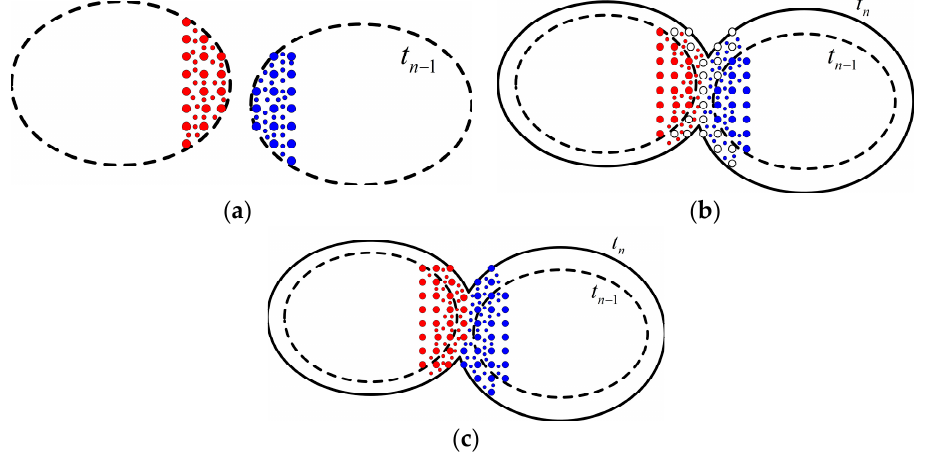
Figure 2. Schematic representation of the particle level set method for polycrystals growth: ( a ) two crystals are distinguished; ( b ) Undyed nodes in the crystalline colors of their nodes at time t n ´ 1 phase are captured by particle level set method at time t n . The dyed particles move to new positions; ( c ) Color the undyed nodes by the colors of the nearest particles at time t n , determine the boundary of the two crystals.